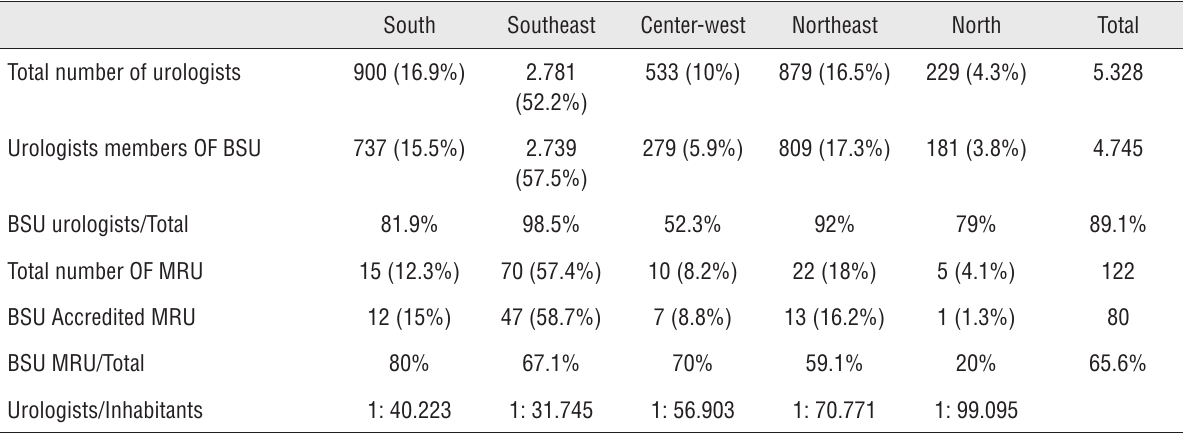
Table 1 - Urology Demographic Data in